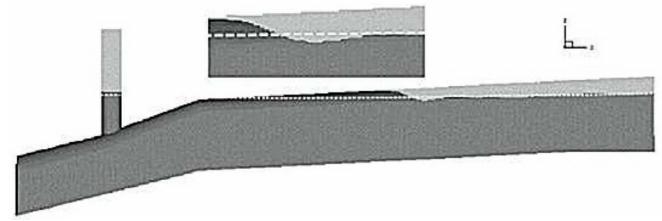
Figure 10. Comparison between the interface and water surface profiles of the 1D–3D coupled method and the virtual slit method